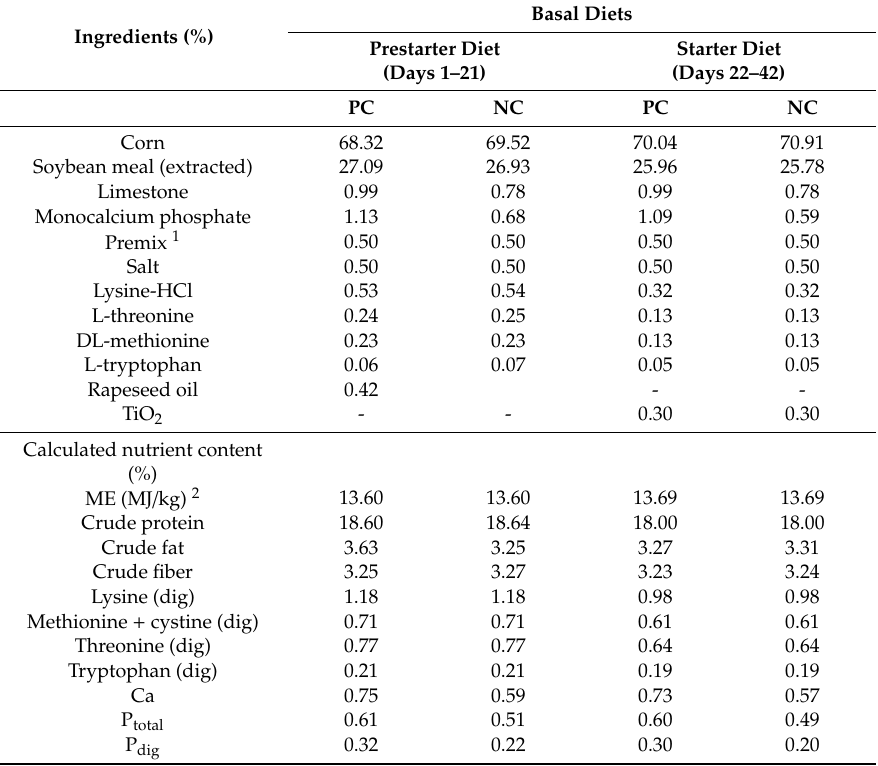
Table 1. Composition of the positive control (PC) and negative control (NC) diets and their calculated nutritional